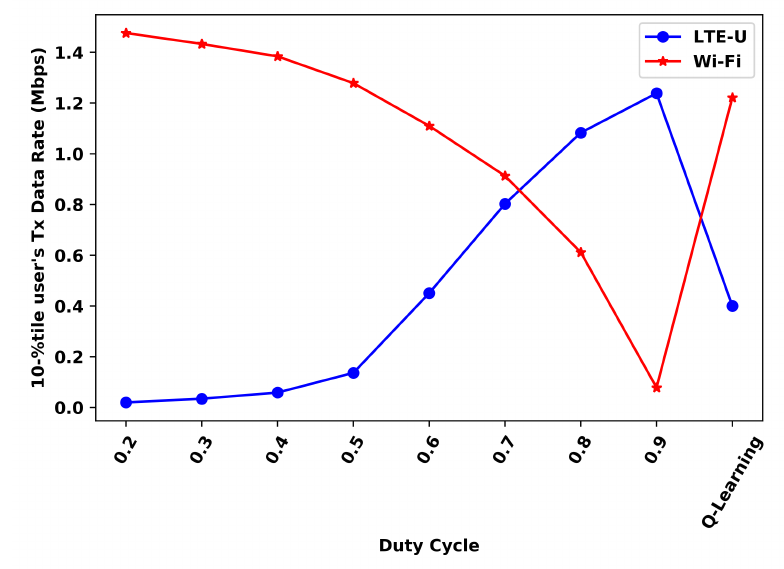
Figure 11. 10th-percentile user’s transmitted data